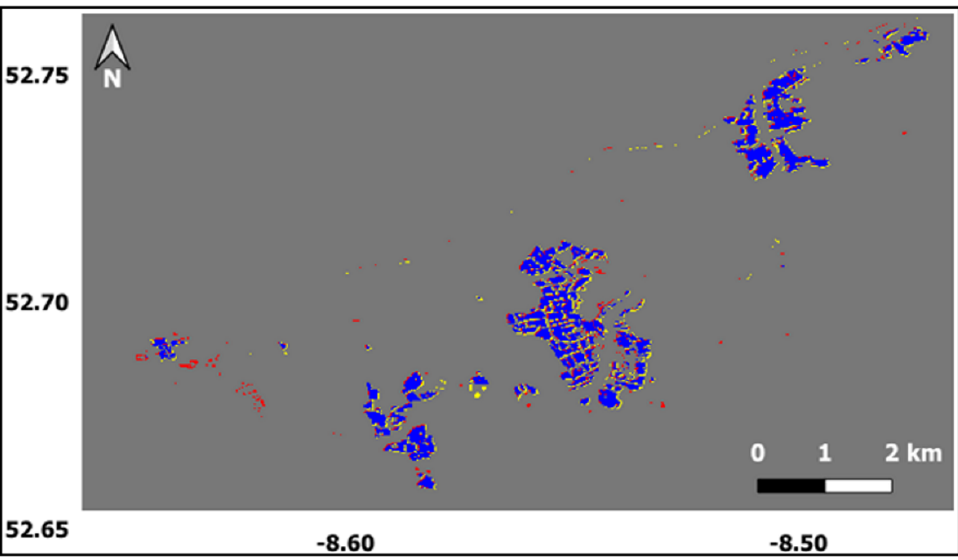
Figure 15. Areas classified as open floodwater by AUTOWADE and CEMS for the Springfield Clonara case study (EMSR 429). Blue: floodwater in both CEMS-derived and AUTOWADE-derived maps; red: floodwater only in the CEMS-derived map; yellow floodwater only in the AUTOWADE-derived map.